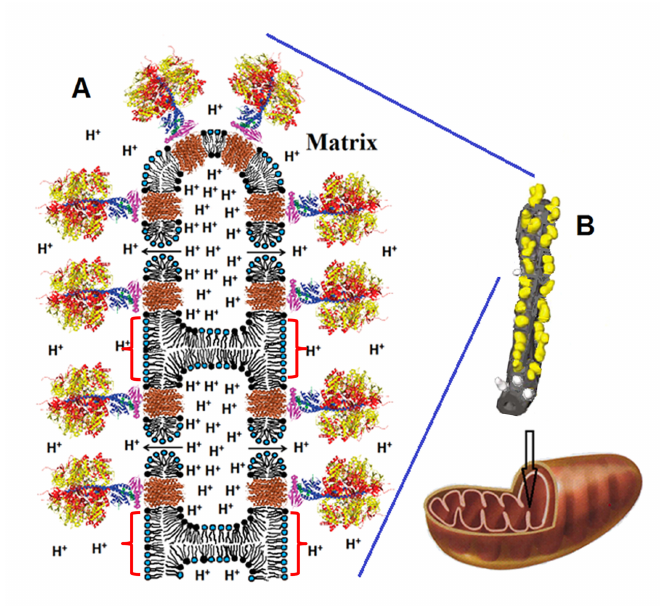
Figure 13. Illustration of Gasanov et al’s hypothesis suggesting the inverted micellar organization of cristae membranes (shown by red brackets). Reproduced with permission from Gasanov et al. [102], Biochim. Biophys. Acta.; published by Elsevier,